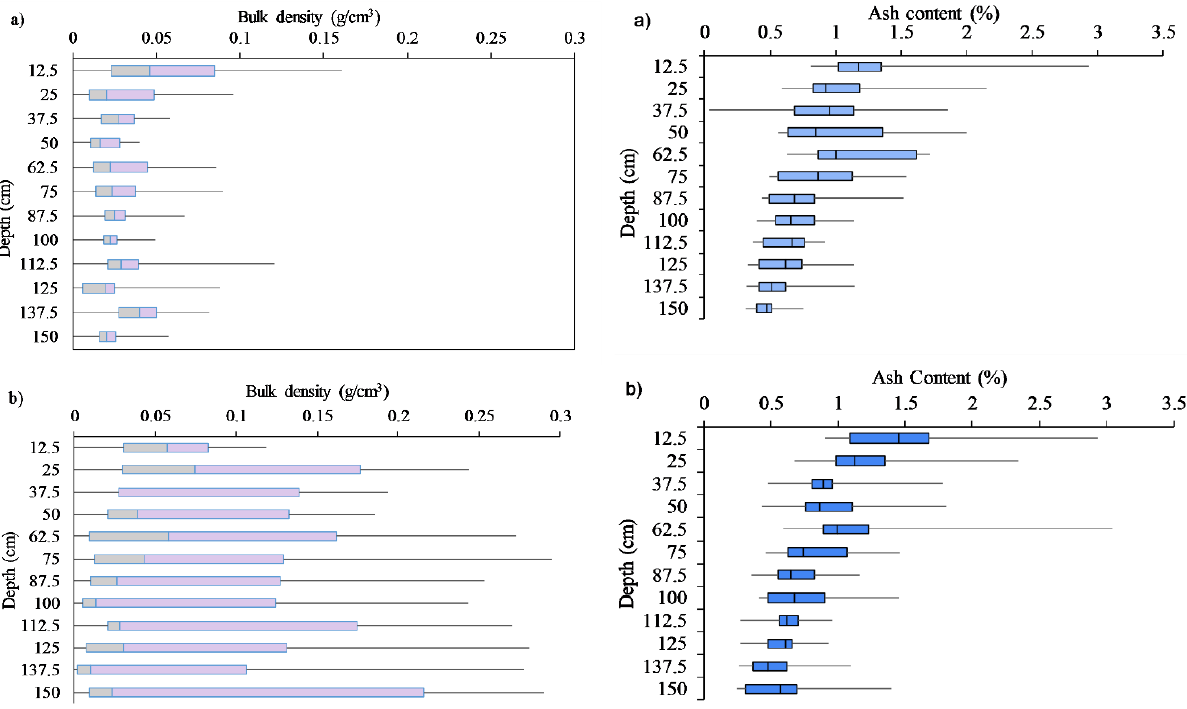
Figure 2. Boxplot of bulk density values versus depth for (a) Transect 1 and (b) Transect 2.